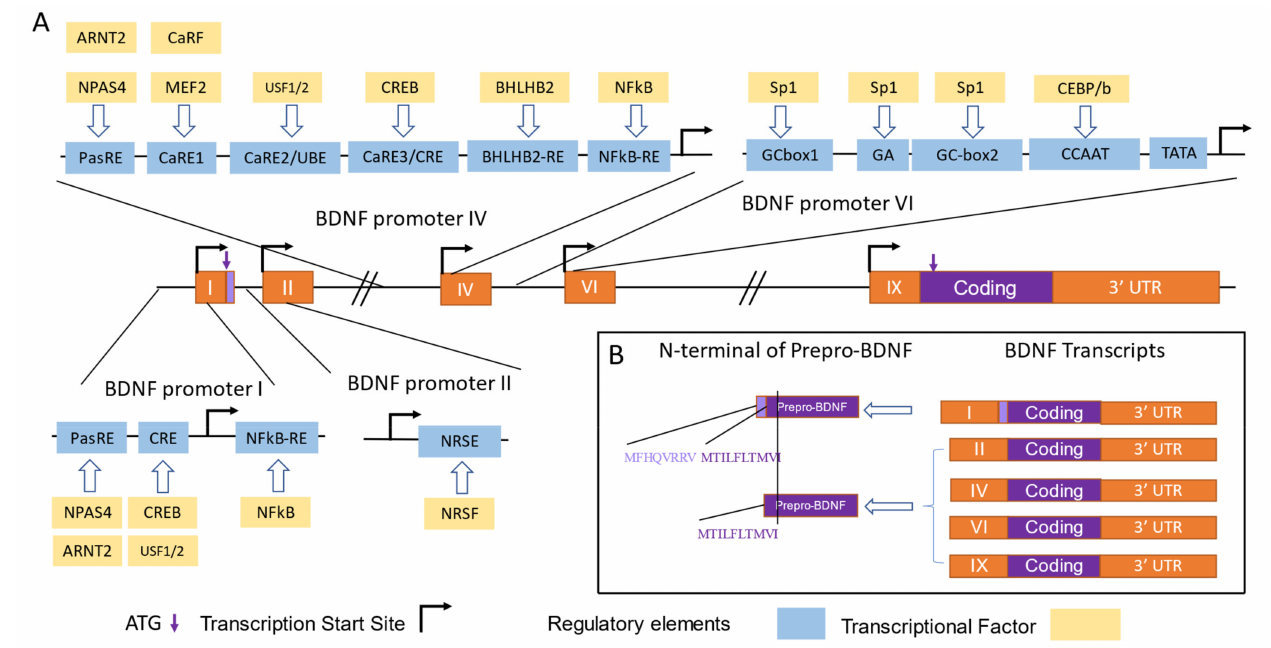
Figure 3. Translational and transcriptional control of BDNF by Promoters I, II, IV, and VI. ( A ) Transcriptional factors (TFs) and regulatory elements involved in the regulation of activity- dependent transcription from BDNF Promoters I, II, IV, and VI are depicted according to [2,47,50]. The orange boxes represent exons, the black lines represent introns, the bent lines with arrows repre- sent the transcription start site, the purple arrows indicate the translation start site (ATG), the blue boxes represent regulatory elements, the yellow boxes represent TFs, the purple boxes represent Bdnf coding sequences or pre-pro-BDNF, and the light purple boxes represent the extended N-terminus of pre-pro-BDNF translated by Promoter I-driven transcripts. The abbreviations of the TFs and the regulatory elements are as follows. For Promoter I, neuronal PAS domain protein 4 (NPAS4) and aryl hydrocarbon receptor nuclear translocator 2 (ARNT2) bind with the basic helix–loop–helix PAS transcription factor response element (PasRE), nuclear factor kappa B (NF κ B) binds with NF κ